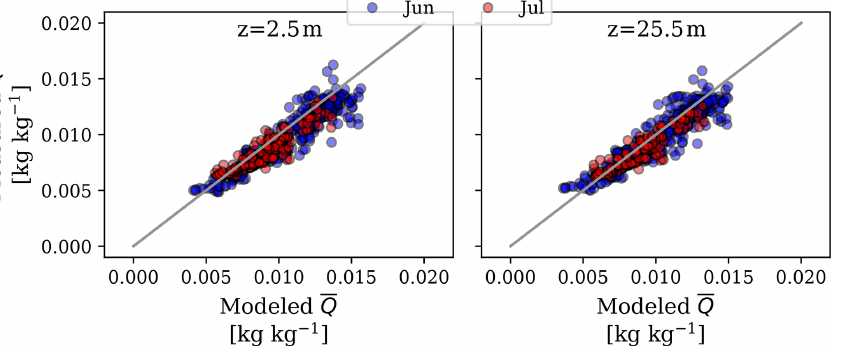
Figure 6. Scatter plots of observed (BUBBLE) versus simulated (VCWG) values of specific humidity for different altitudes and months; each data point corresponds to a 1h comparison between the model and